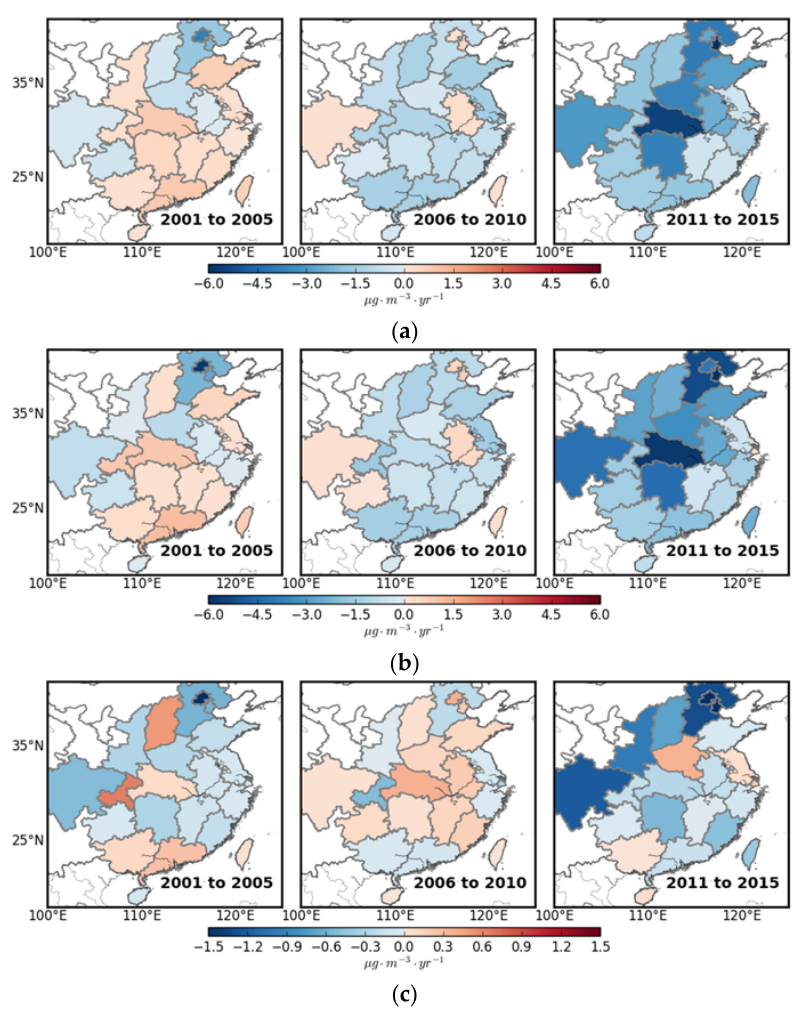
Figure 7. Averaged PM 2.5 trends in ( a ) rural and ( b ) urban areas in different provinces during the three FYP periods. ( c ) The differences in the averaged PM 2.5 trends between rural and urban areas in different provinces during the three FYP periods.